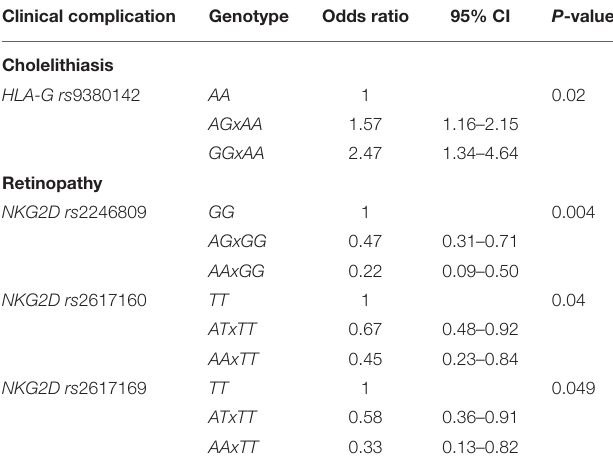
TABLE 3 | Significant SNPs, according to the clinical variable, in logistic regression